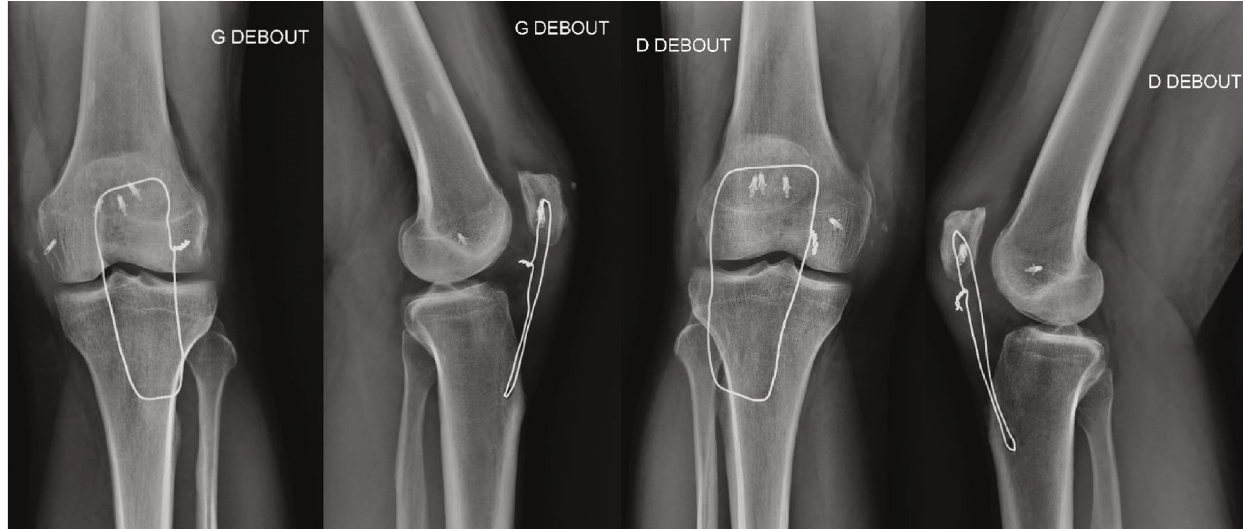
Figure 3: Radiographic control 10 weeks after surgery.